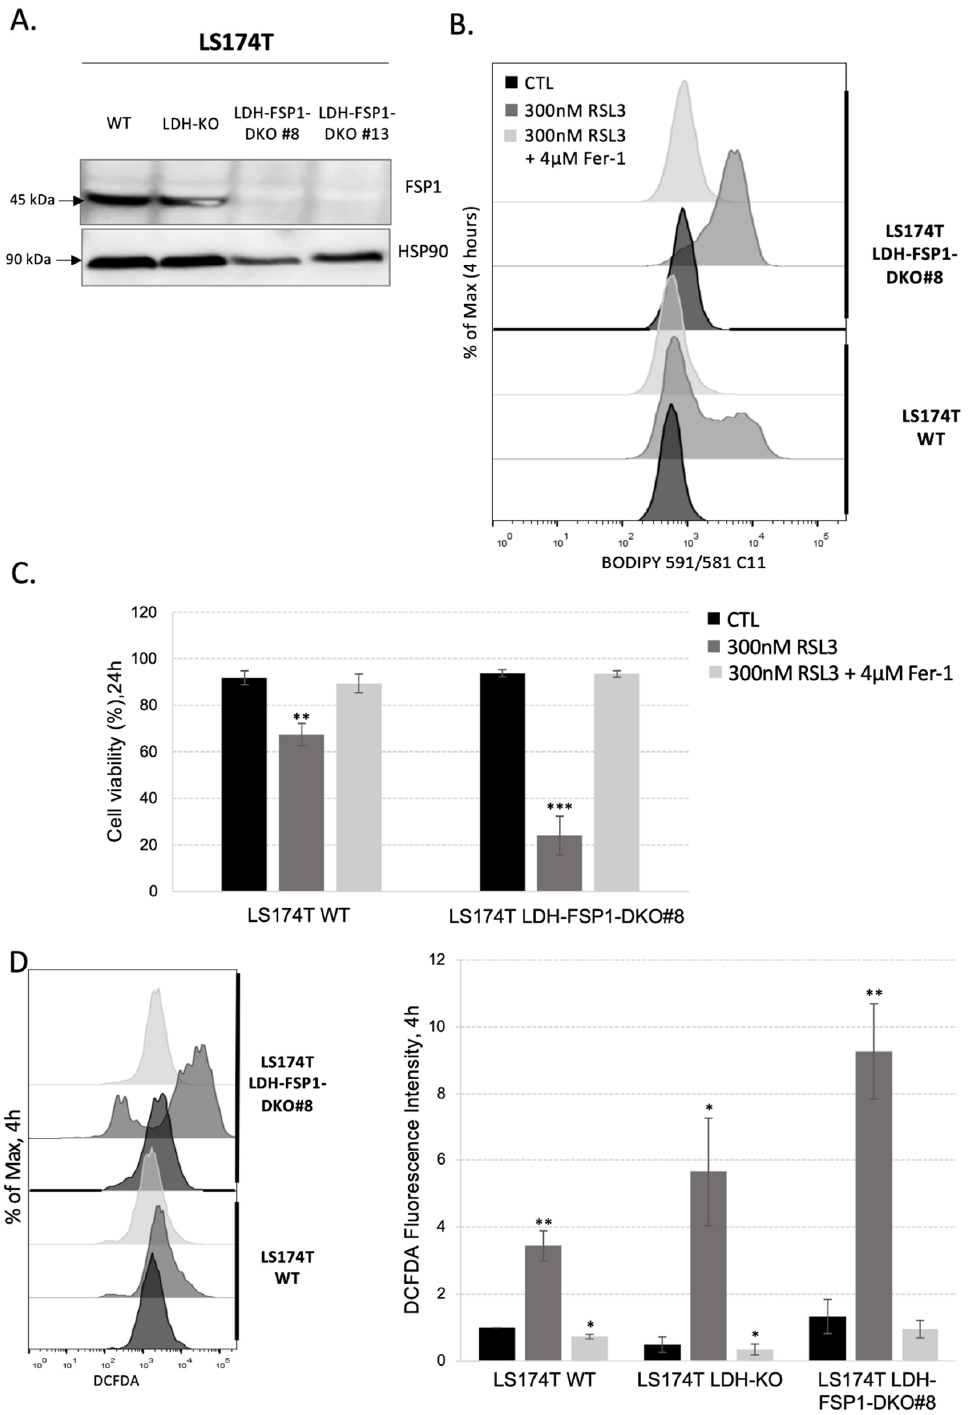
Figure 4. Suppression of the Warburg effect is necessary to induce ferroptosis in LS174T cells with FSP1-KO genetic background. ( A ) The protein expression of FSP1 was analyzed in LS174T WT, LDH-KO and two independent LDH-FSP1-DKO (#8 and #13) clones. Three independent experiments were performed, and representative blots are shown. ( B ) Lipid hydroperoxide content was measured in LS174T WT and LDH-FSP1-DKO #8 cells 4 h upon seeding in media supplemented or not with 300 nM RSL3 and 4 µ M Fer-1. Presented histograms are representative of three independent experiments. ( C ) Cell viability was measured in LS174T WT and LDH-FSP1-DKO #8 cells using PI staining method (see Section 2). Cells were seeded in media supplemented or not with 300 nM RSL3, in the